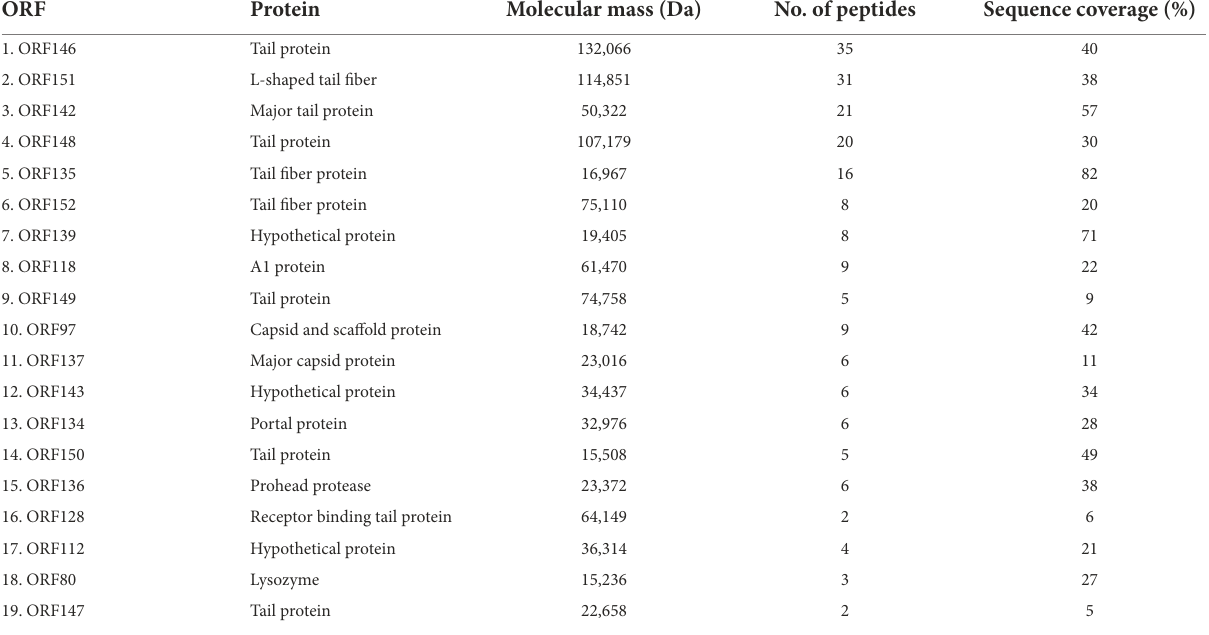
TABLE 2 Identification of the phage STWB21 proteins by